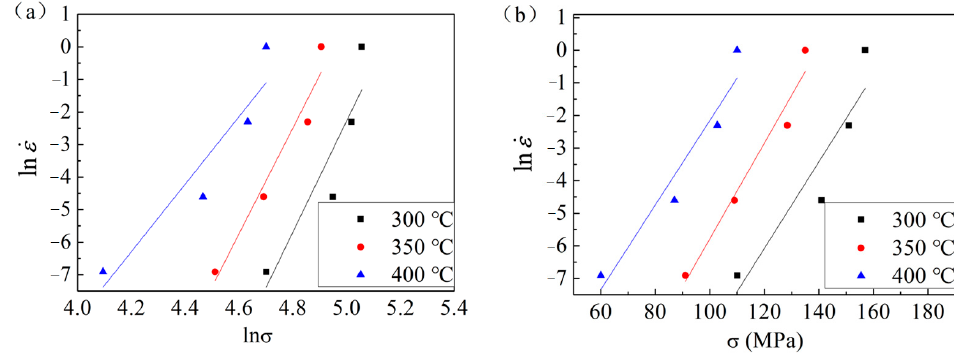
Figure 6. The fitting of linear relationships: ( a ) lnε(cid:4662) − lnσ ; ( b ) lnε(cid:4662) − σ . Thus, the n 1 and β average values were calculated as 14.567 and 0.136 MPa − 1 , respectively, for the peak data. In this case, the mean value of α was calculated as 9.336 × 10 − 3 MPa − 1 based on α = β /n 1 .